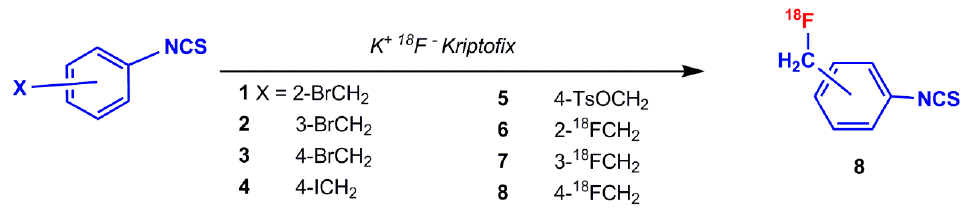
Figure 8. Synthesis of (fluoro– 18 F) ethane isothiocyanatobenzene by various substrates (1–8). Oligonucleotides